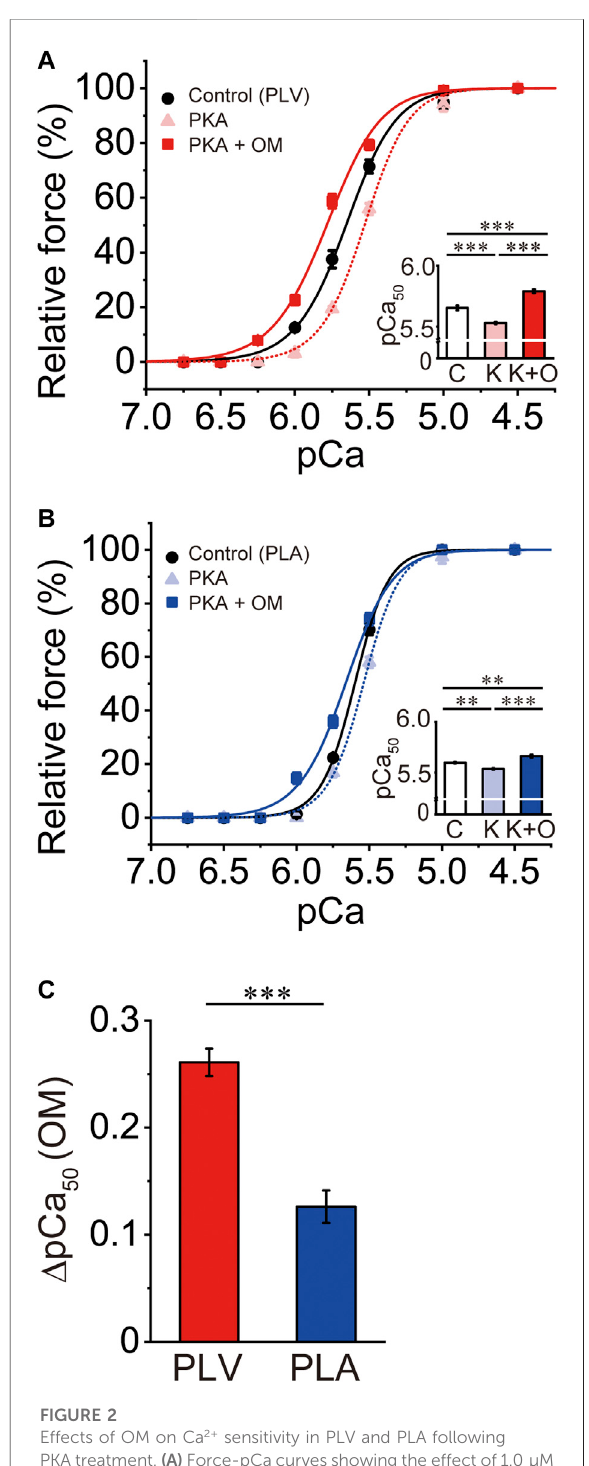
FIGURE 2 Effects of OM on Ca 2+ sensitivity in PLV and PLA following PKA treatment. (A) Force-pCa curves showing the effect of 1.0 μ M OM on Ca 2+ sensitivity following PKA treatment in PLV. Black circles and solid lines, control (before PKA treatment); light redtrianglesanddottedlines,afterPKAtreatment;redsquaresand solid lines, 1.0 μ M OM after PKA treatment. Inset, pCa 50 values under varying conditions. C, control (without OM); K, PKA treatment; K + O, 1.0 μ M OM after PKA treatment. *** p < 0.001